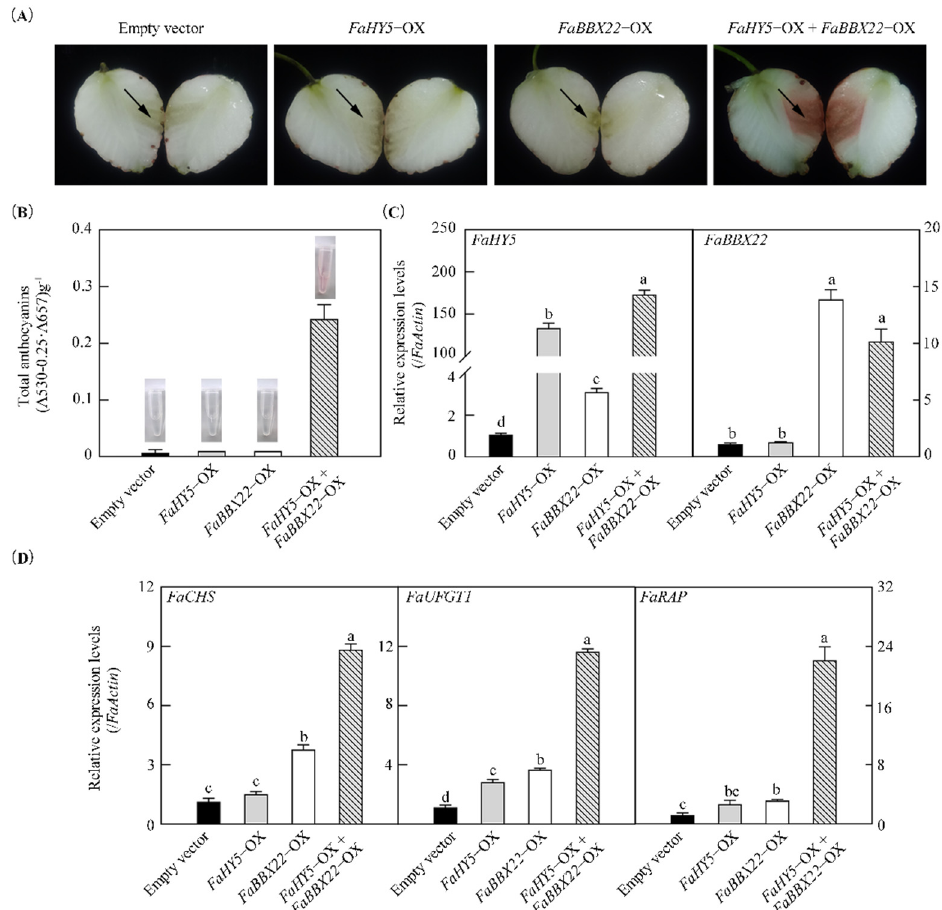
Figure 7. FaBBX22 and FaHY5 jointly promote the anthocyanin accumulation in white fruit straw- berry variety (‘Snow white’). ( A ) Phenotypes of white flesh after infiltrating FaBBX22 , FaHY5 and FaBBX22 / FaHY5 for 5 days. The arrow points to the infiltration site; ( B ) Anthocyanin contents and extracts of strawberry fruits; ( C ) The expression levels of FaHY5 and FaBBX22 in different infiltration treatments; ( D ) The relative expression levels of FaCHS , FaUFGT1 and FaRAP in different infiltration treatments. Infiltrating empty vector pCAMBIA1301 − 35S − Nos acts as control. Error bars represent three independent replicates. Different letters above the bars indicate significantly different values ( p < 0.05) according to a Least Significant Difference (LSD) test.